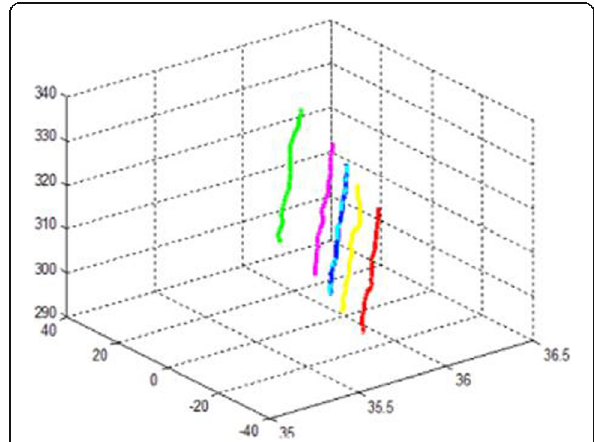
Fig. 11 Structured-light stripe center 3D coordinates in a different position of plane